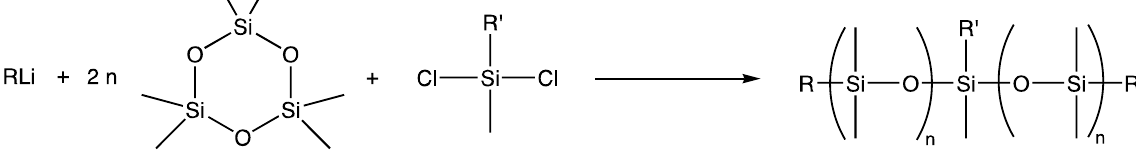
Scheme 5. Siloxane Macromer Structural Segments.